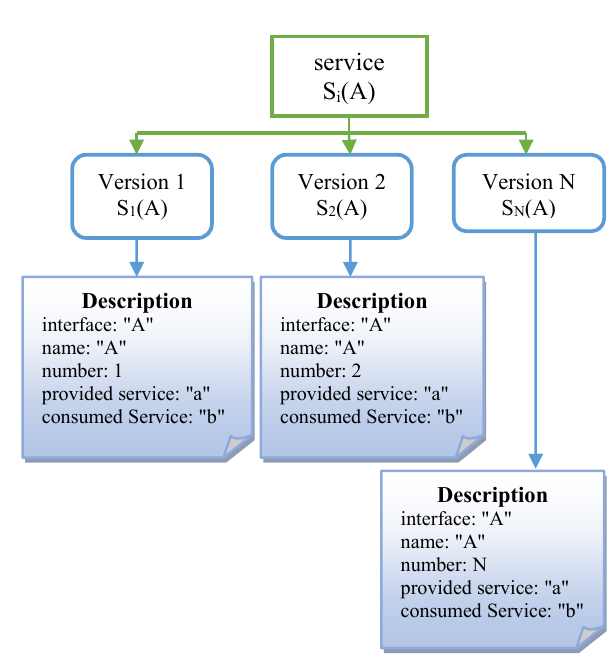
Figure 8 . Description of versions Service